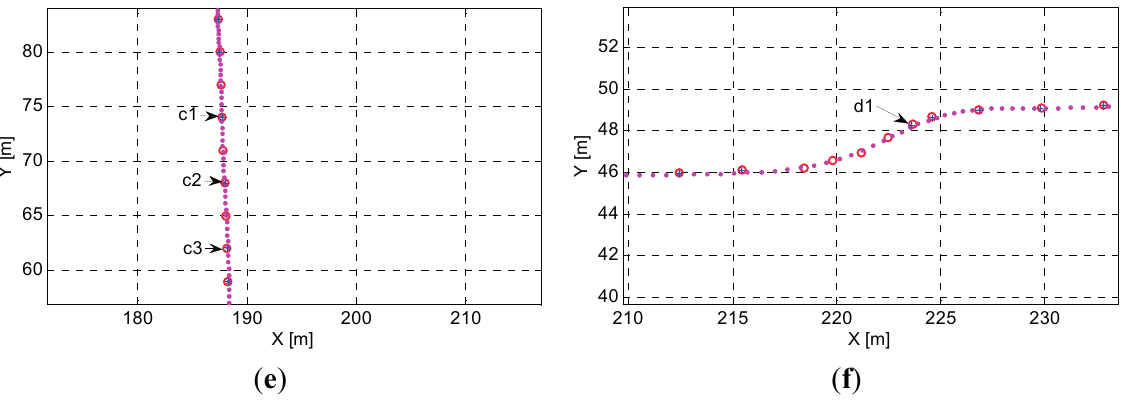
Figure 15. Estimation results with consideration of detection errors at 4 different sections of the test route: ( a ) Comparison of estimated positions with absolute positions of magnetic markers; ( b ) Estimation errors; ( c ) Section A; ( d ) Section B; ( e ) Section C; ( f ) Section D. Table 1. Changes in estimation errors (cm) by considering detection failure of magnetic